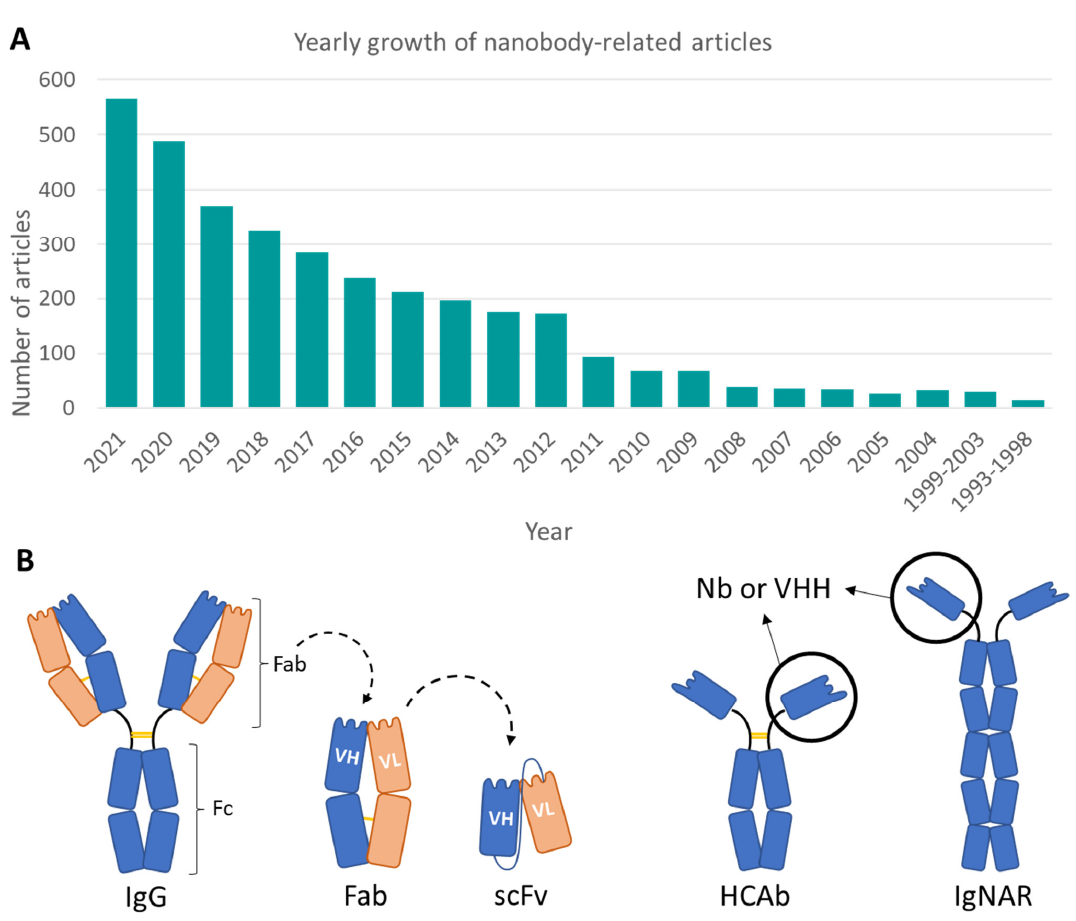
Figure 1. ( A ) Articles per-year based on a “nanobody” search in PubMed. ( B ) Differences between traditional antibodies and their derivatives with respect to HCAbs. A classical IgG antibody is made up of 12 immunoglobulin domains, distributed in two different pairs of chains: heavy (in blue) and light (in orange). It is functionally divided into the Fc region and the two Fab fragments, where the recognition region is located. On the other hand, both HCAbs and IgNARs are made up of one pair of a single chain type. Different antibody fragments, such as the Fab or a single-chain fragment (scFv) can be derived or constructed. The latter is formed by the heavy and light variable domains, joined by a linker. In contrast, Nbs or VHH are formed solely by the recognition domain of HCAbs or IgNARs.